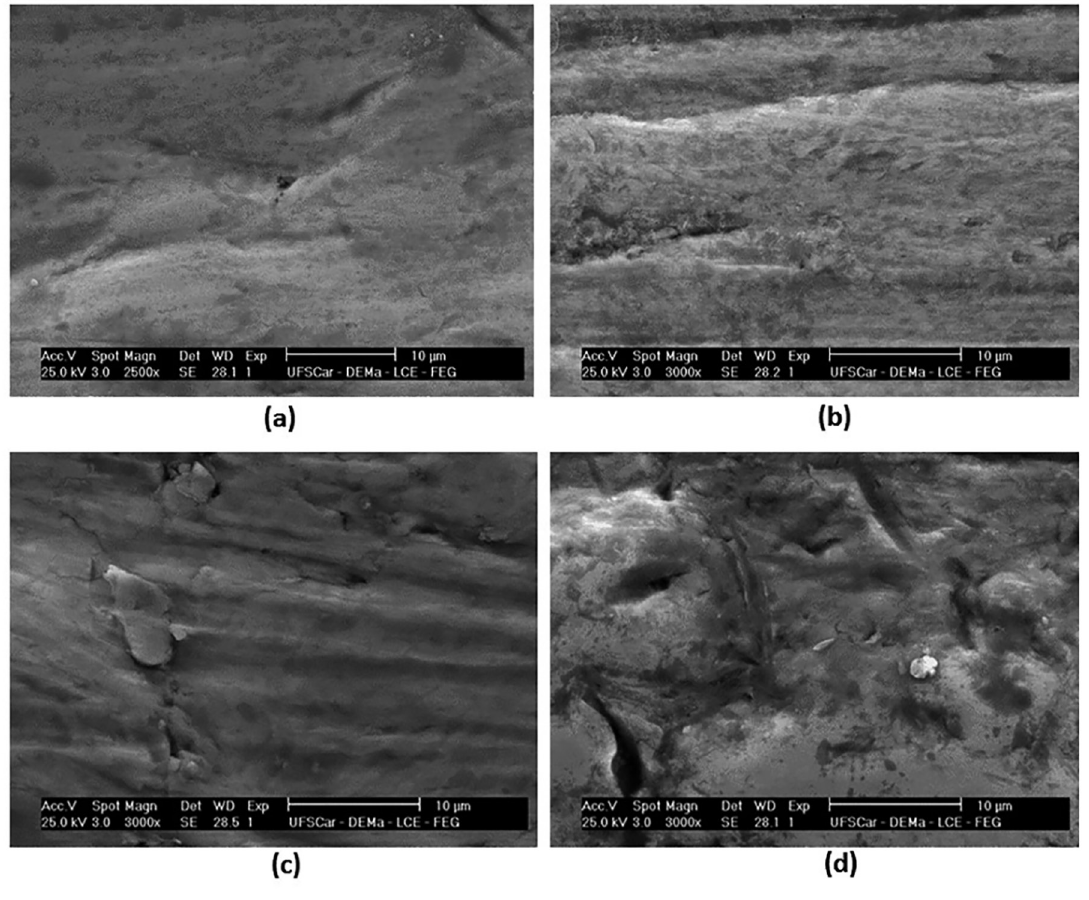
Figure 12: Wear trails for conditions of (a) pulling the torch, (b) pushing the torch, (c) one deposited layer and (d) two deposited layers. welded layer, Figure 12(c), it can be seen deep wear